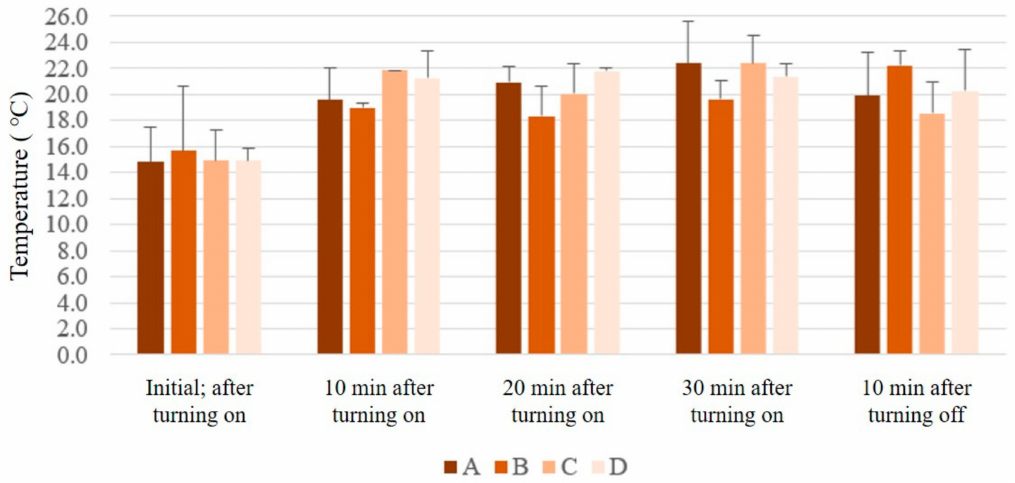
Figure 7. Internal temperature changes of technical material samples according to exposure time.